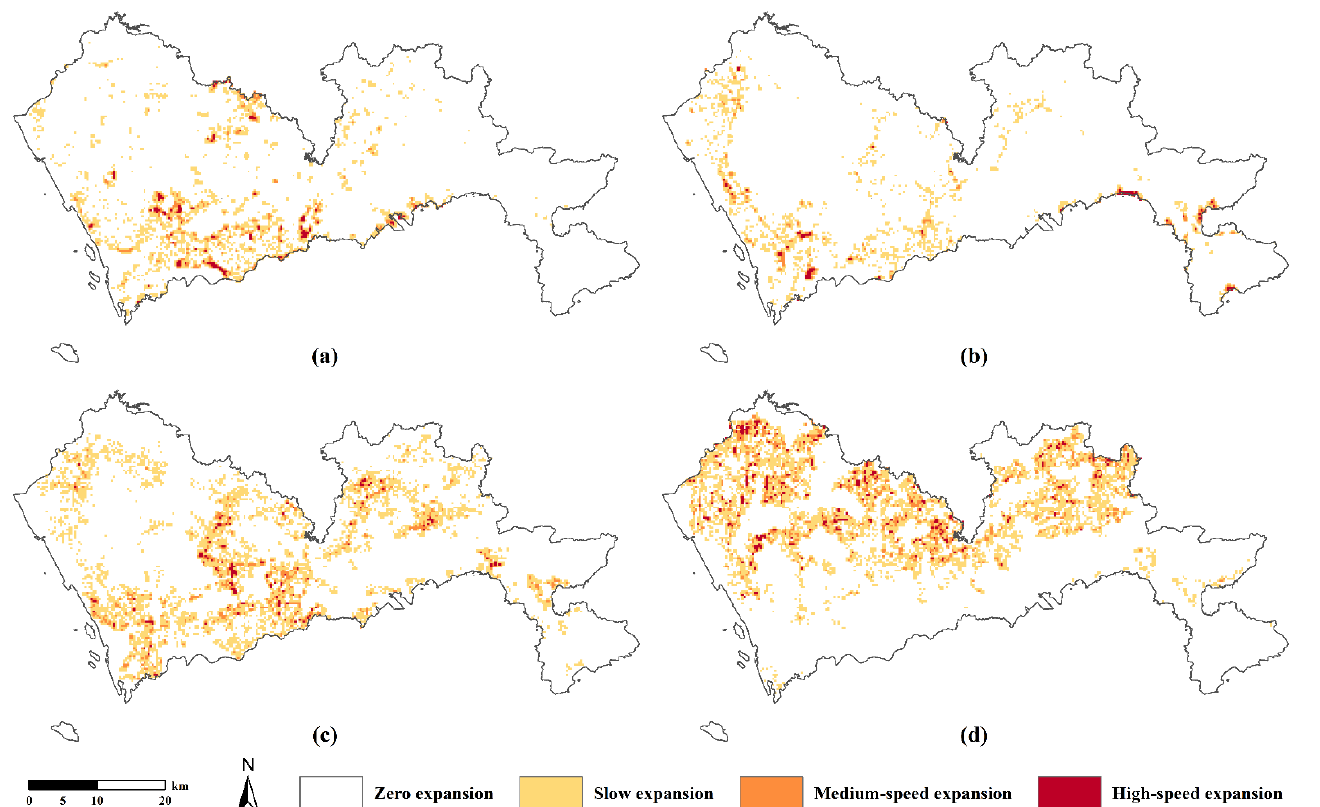
Figure 13. Spatial distribution of urban 3D expansion intensity in Shenzhen, 2014 – 2034.